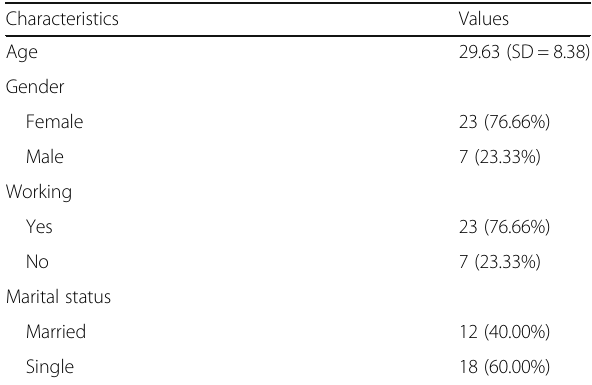
Table 1 Socio-demographic data ( n =